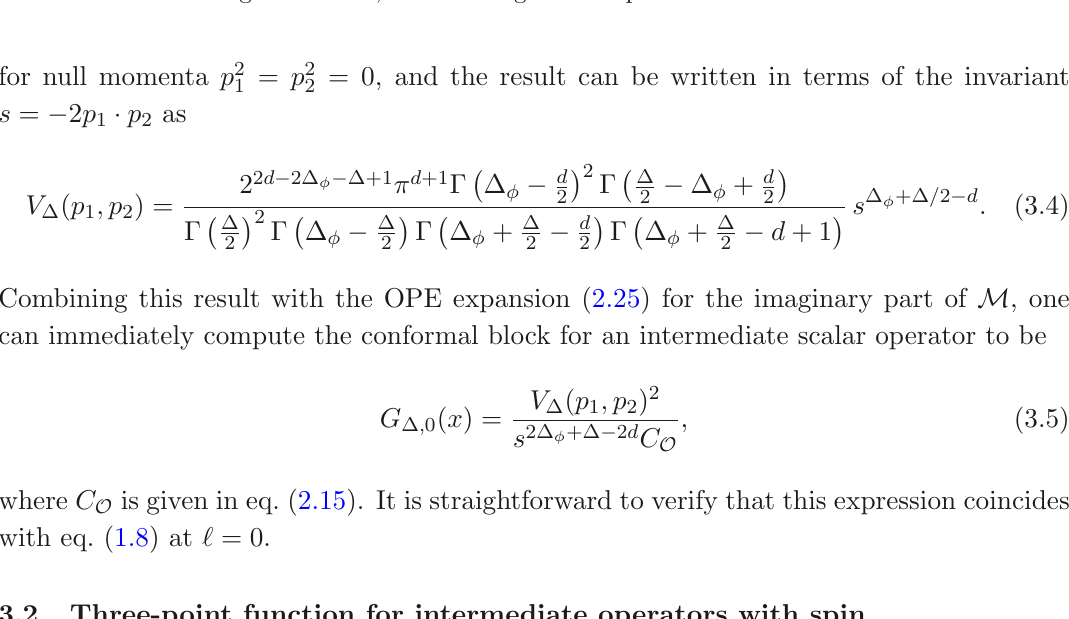
Figure 3 . Feynman diagram representation of eq. (3.3), in which the time-ordered 2-point function is indicated with a single solid line, and the Wightman 2-point functions with double